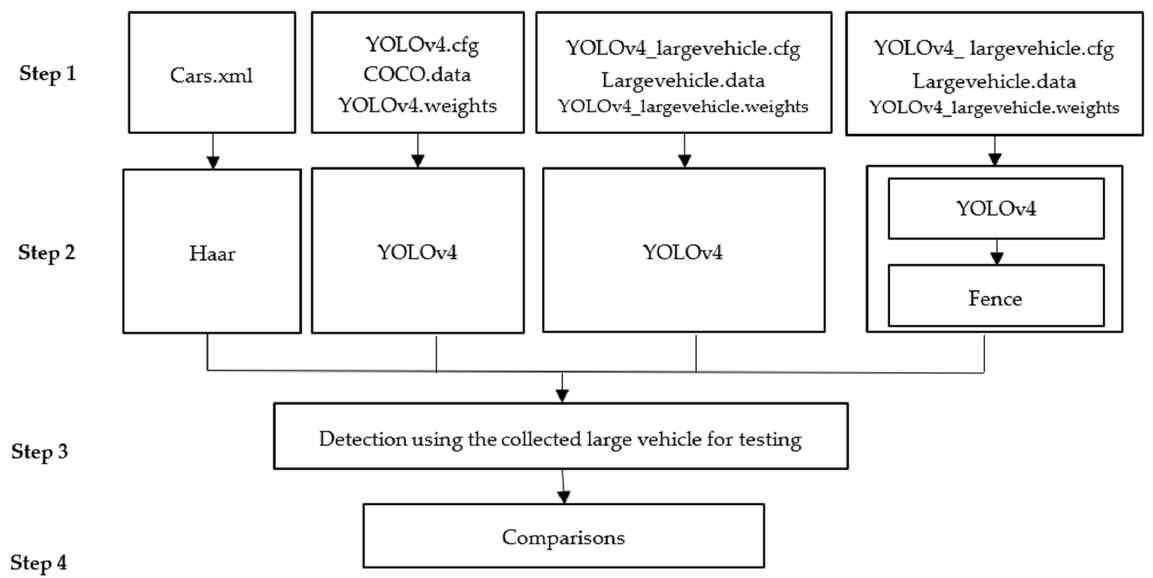
Figure 2. Flowchart for improving detection accuracy.